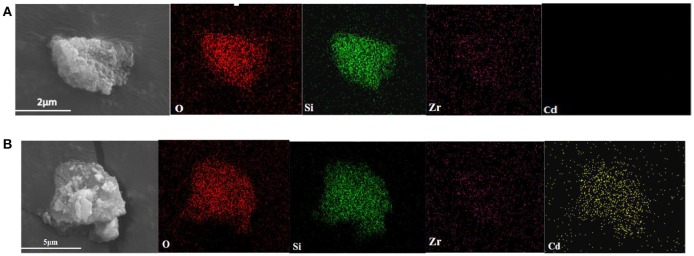
SEM images of ZSR-P (A) and adsorbed Cd2+ product (B).